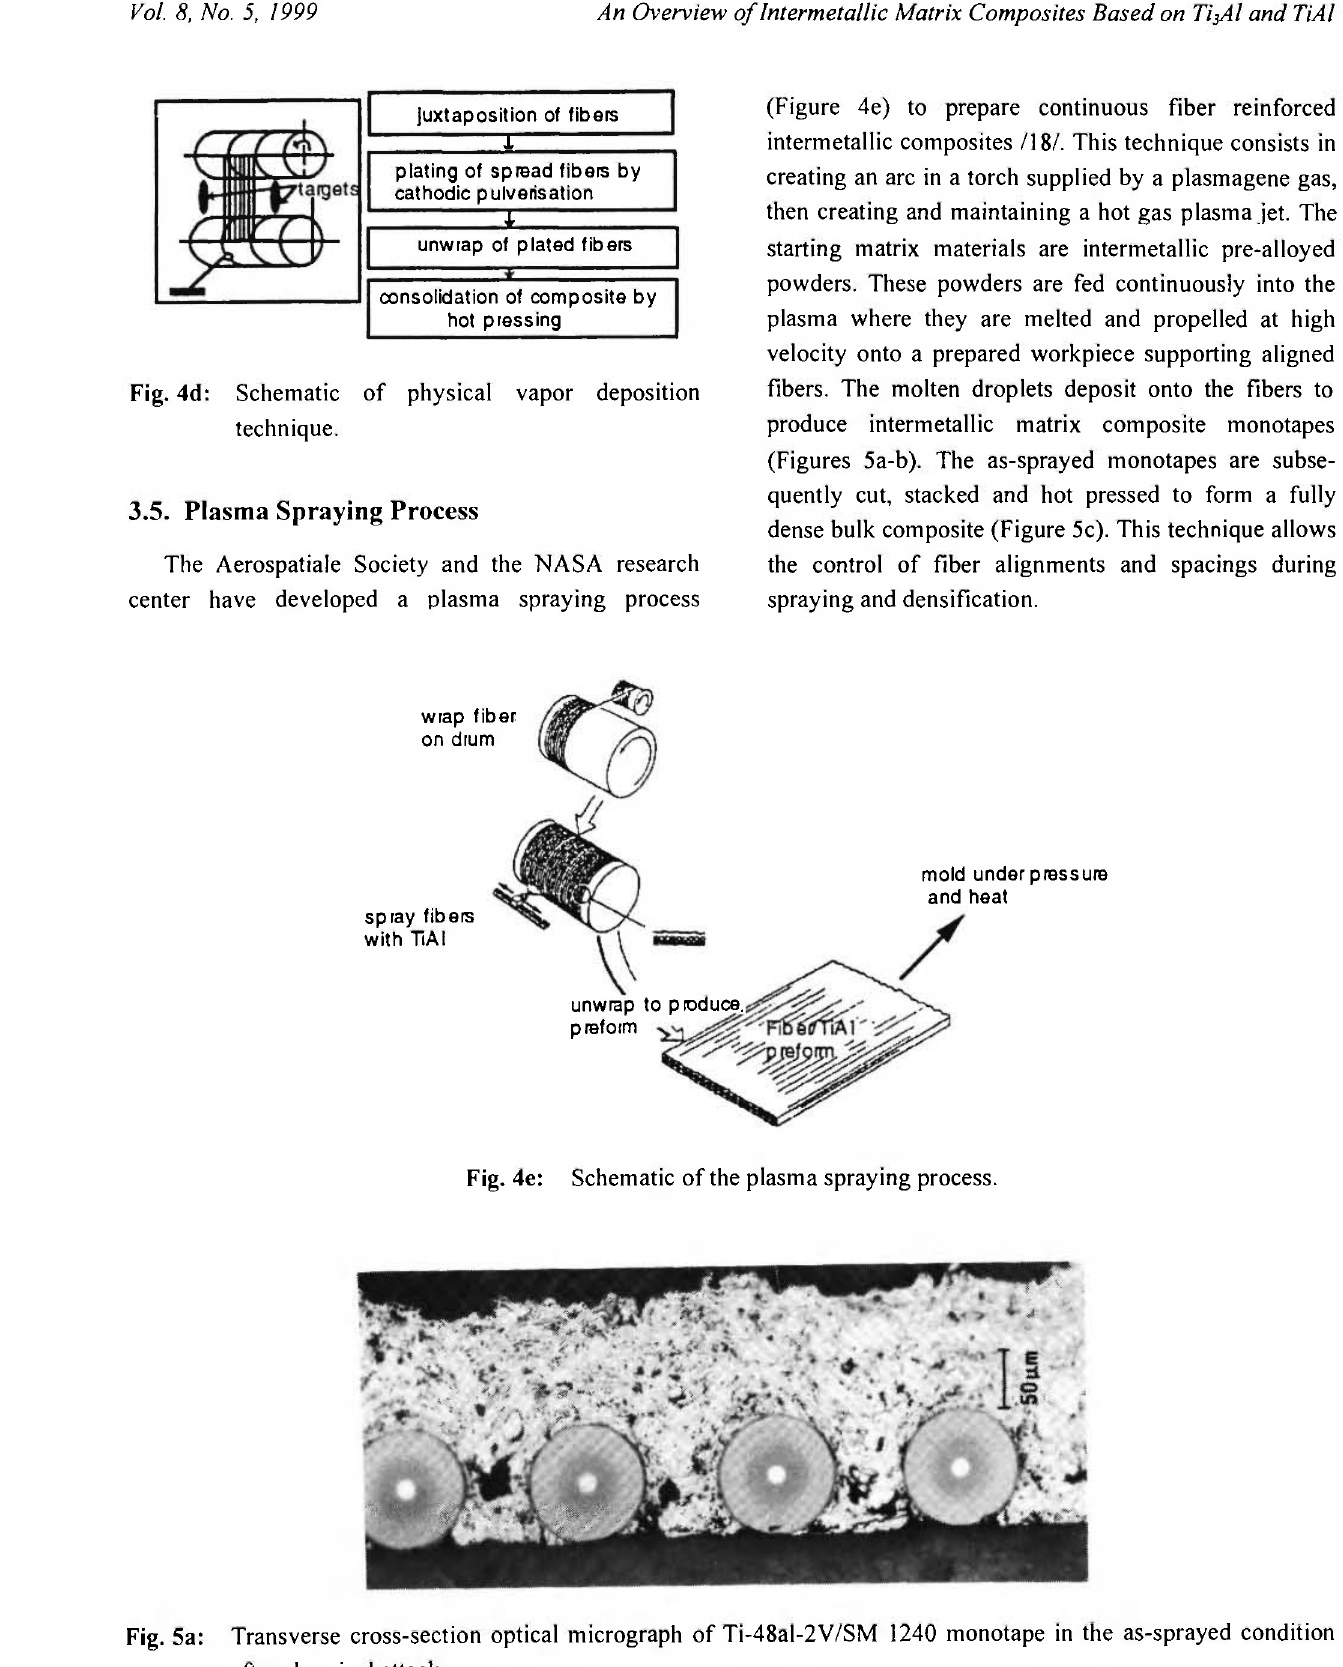
Fig. 5a: Transverse cross-section optical micrograph of Ti-48al-2V/SM 1240 monotape in the as-sprayed condition after chemical